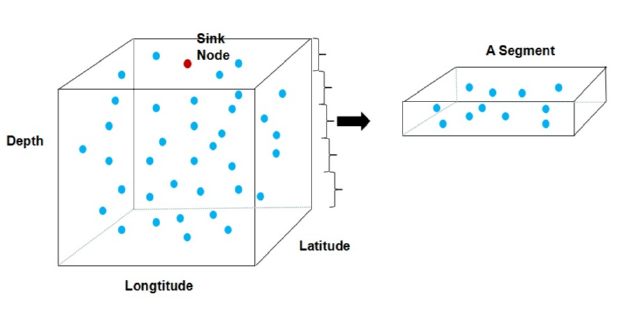
Figure 1. The segment-divided model of the 3-D